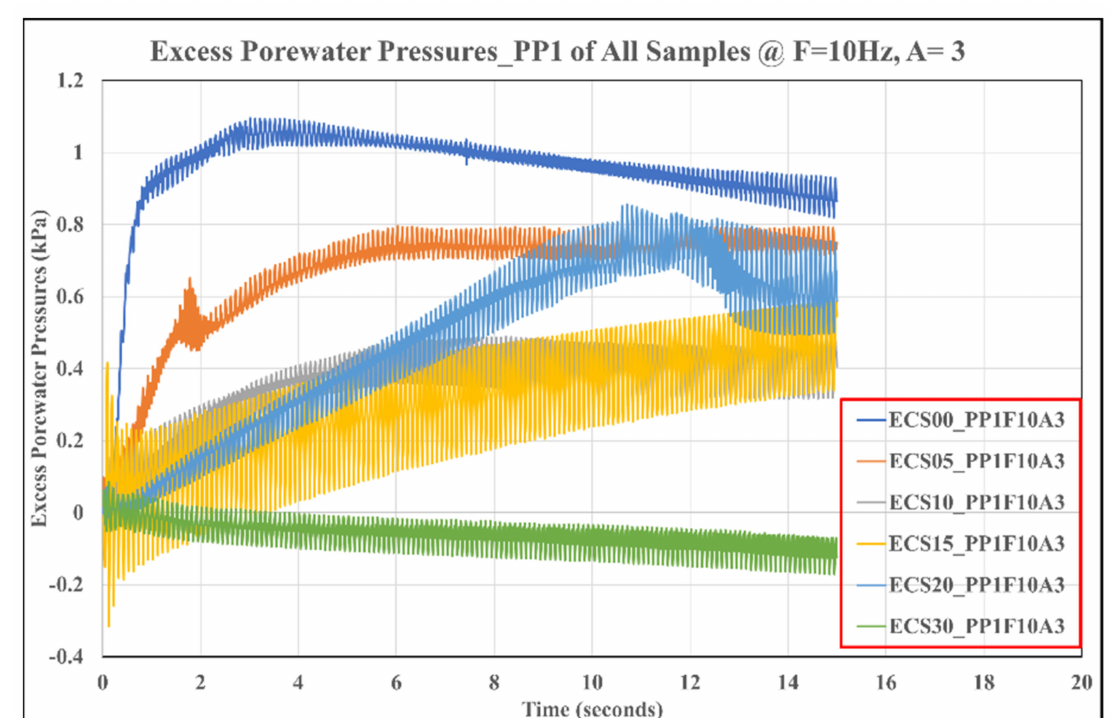
Figure 9. Excess PWP during the second shaking